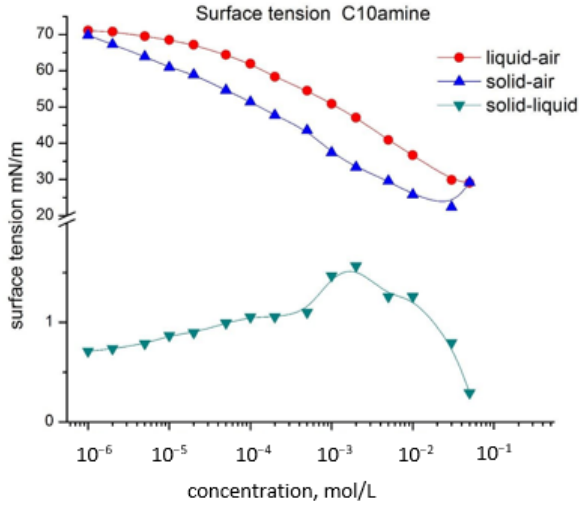
Figure 8. Surface tension of C10 amine solution for different interfaces.